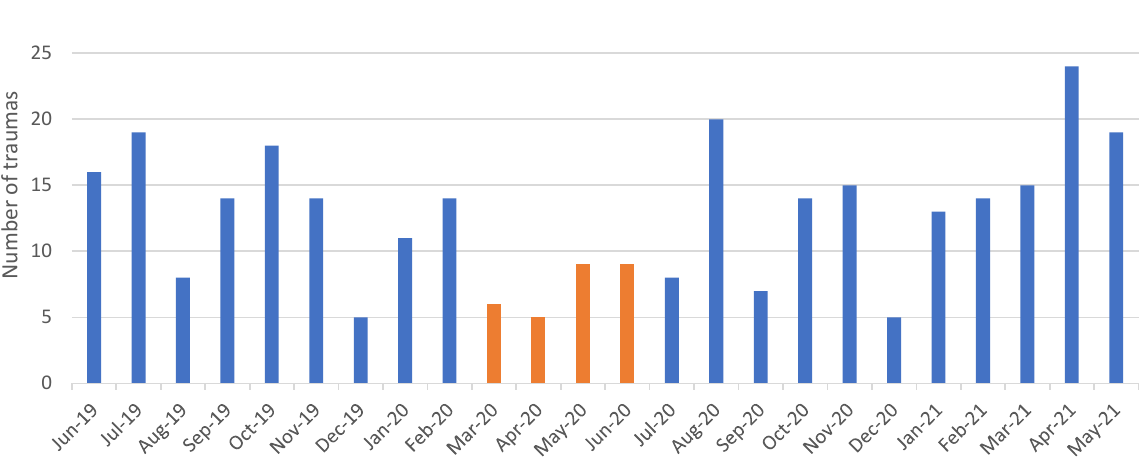
Figure 5. Monthly incidence of TDI. Orange-marked months represent the first main lockdown period.